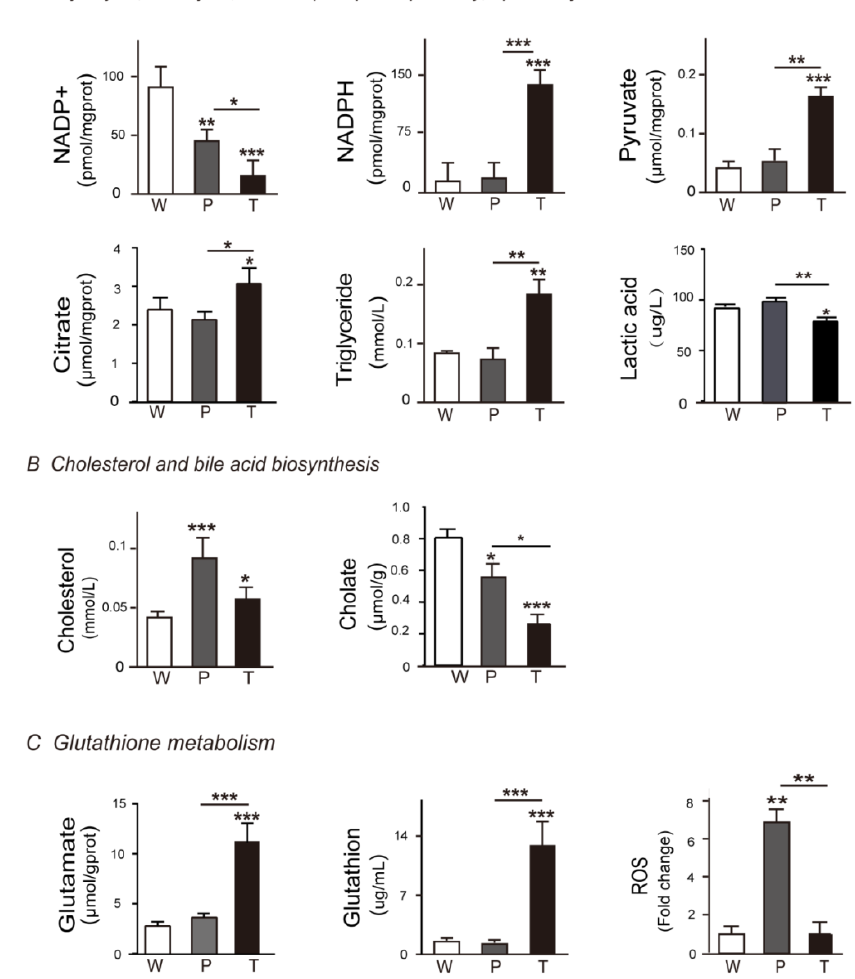
Figure 3. Validation of DEMs (differently expressed metabolites) in HCC, precancerous liver tissues, and normal liver tissues. ( A ) Glycolysis, TCA cycle, pentose phosphate pathway, and lipid biosynthesis correlated key DEMs were validated. ( B ) Cholesterol and bile acid biosynthesis correlated key DEMs were validated. ( C ) Glutathione metabolism correlated key DEMs were validated. The key metabolites involved in Figure 2 were validated using the corresponding methods described in the supplemental information. Abbreviations are the same, as mentioned in Figure 1.